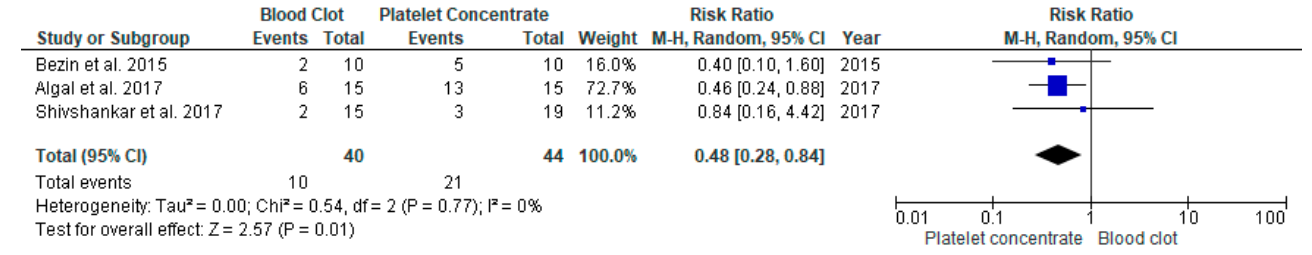
Figure 7. Meta-analysis of vitality response (VR) in regenerative endodontic procedure (REP) using APC or BC.